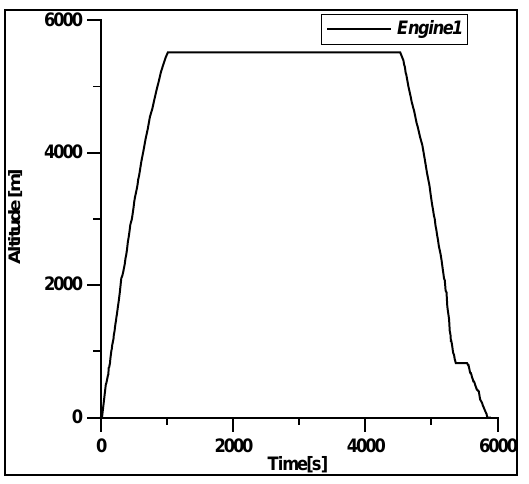
Figure 10. Mission profile. Figure 10. Mission